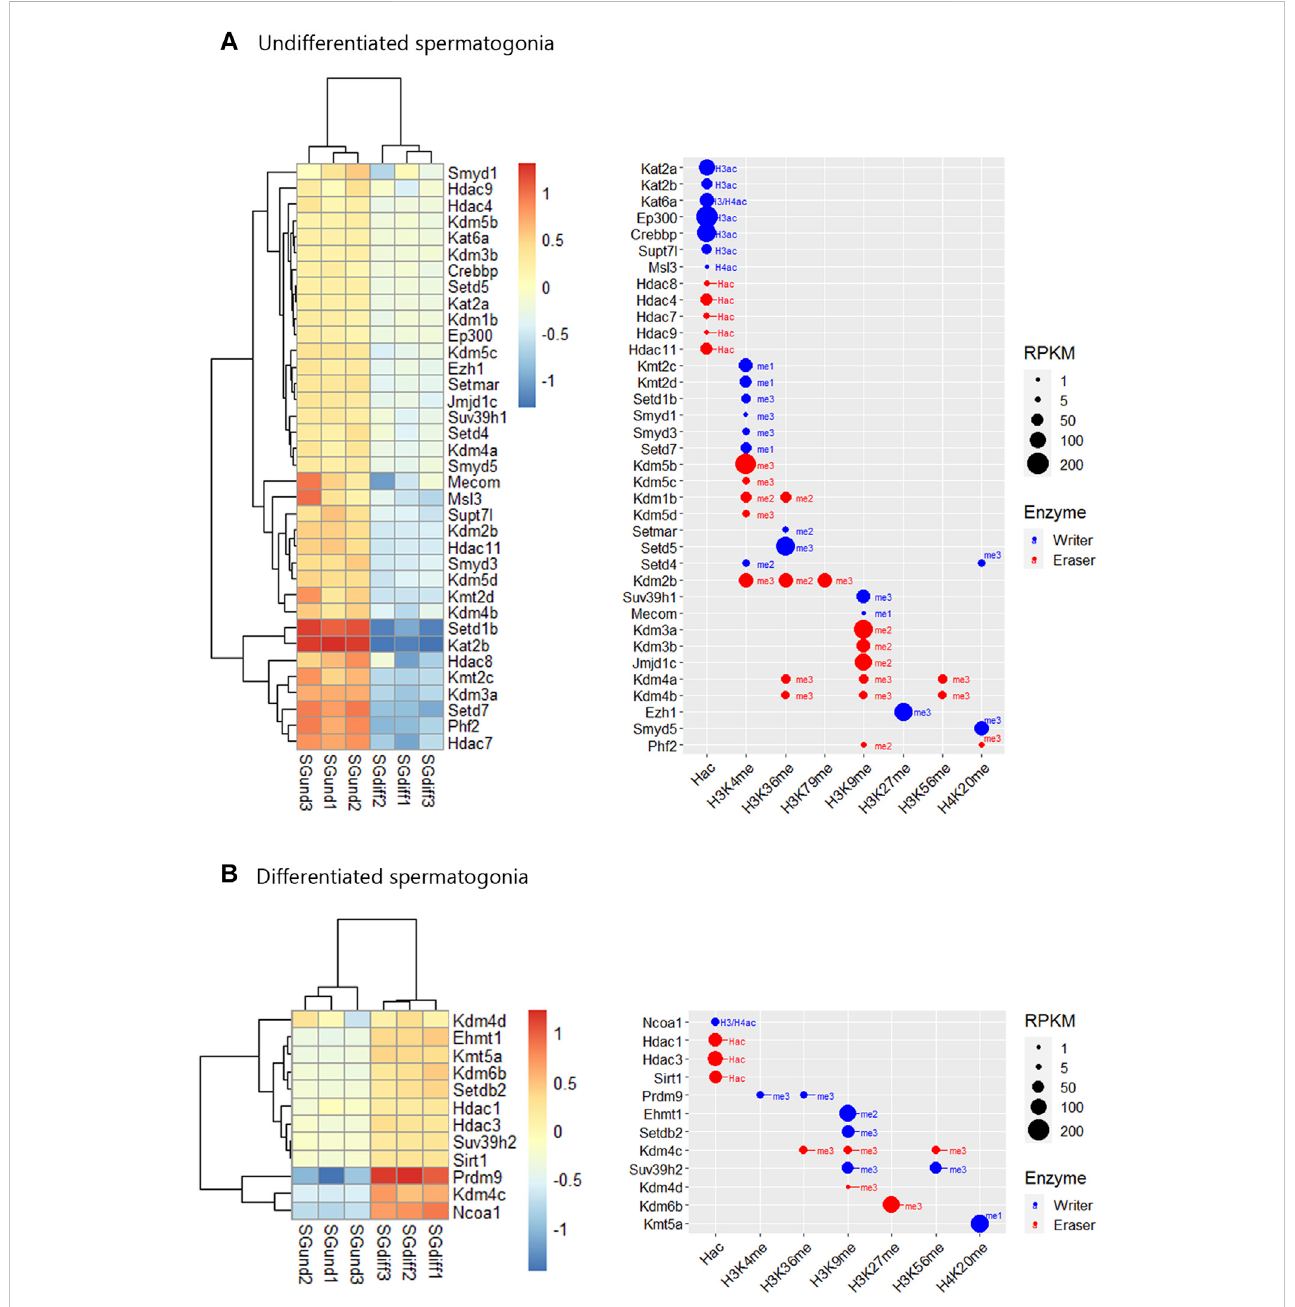
FIGURE 4 Epigenetic histone K writers and erasers upregulation at spermatogonial phase. The left panel indicates the heatmap showing z-score values and the right panel indicates the bubble chart showing enzymes RPKM values in SGund (A) and SGdiff (B) population. Blue dots: writers, red dots: erasers. SGund: spermatogonia Kit-, SGdiff: spermatogonia Kit+. The me1/2/3 reference for each dot indicates the highest methyl position reported for each lysine methylationenzyme.TheH2/3/4acreferenceindicatesthehistonetargetreportedforeachlysineacetylationwriter.Hacindicatesthatlysineacetylation eraser was reported to erase acetylation on all histones